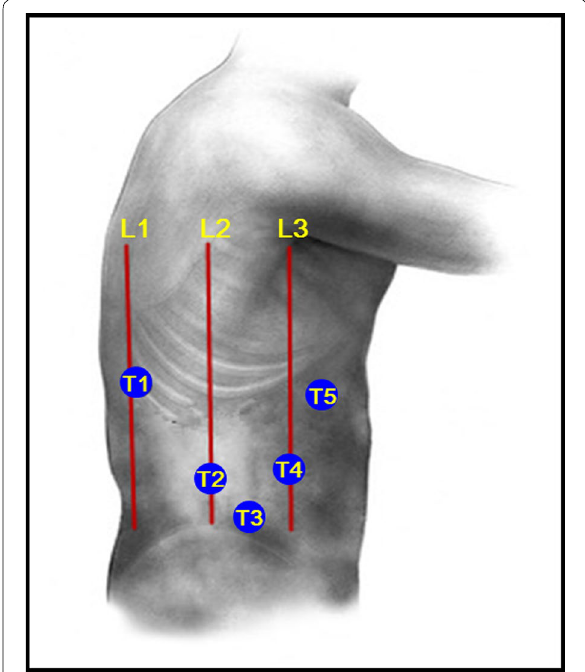
Fig. 2 Trocar placement in the left jackknife position. L1 posterior axillary line, L2 midaxillary line, L3 anterior axillary line, T1 main operat‑ ing hole 1, T2 main operating hole 2, T3 observation hole, T4 auxiliary operation hole 1, T5 auxilliary operation hole